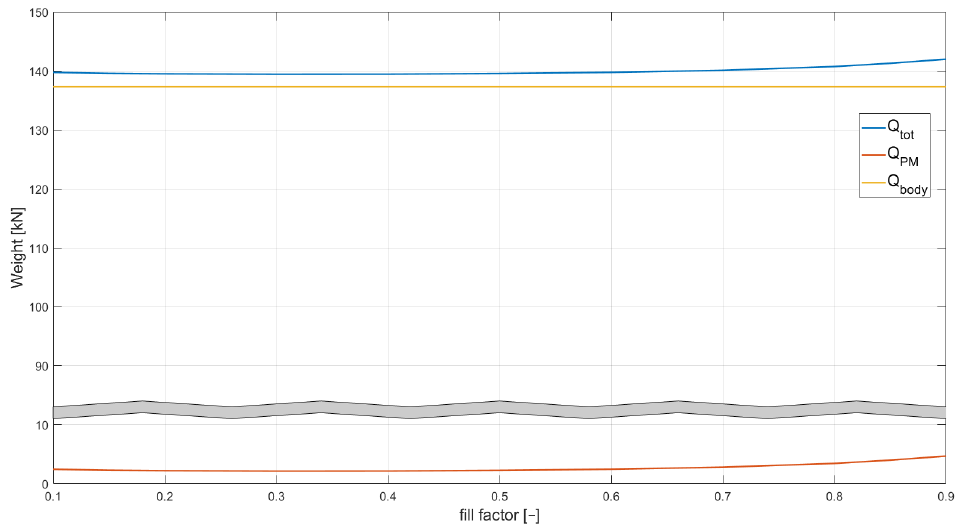
Figure 6. Weights of vehicle body (yellow line), permanent magnets (red line) and sum of both (blue line). Weight of PM is calculated for v lew = 10 m/s.